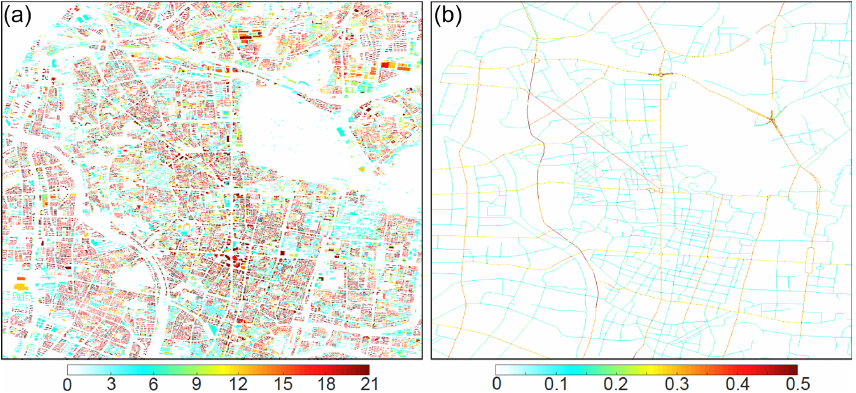
Figure 2. Spatial distribution of (a) building heights (m) and (b) traffic CO emissions (mgcell − 1 s − 1 ) (during rush hours) in the model